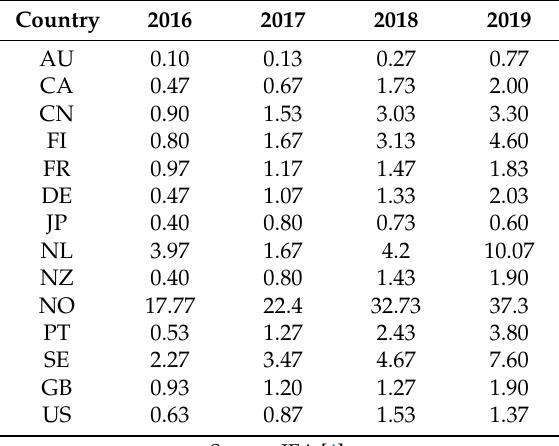
Table 5. Actual values of market share of sales